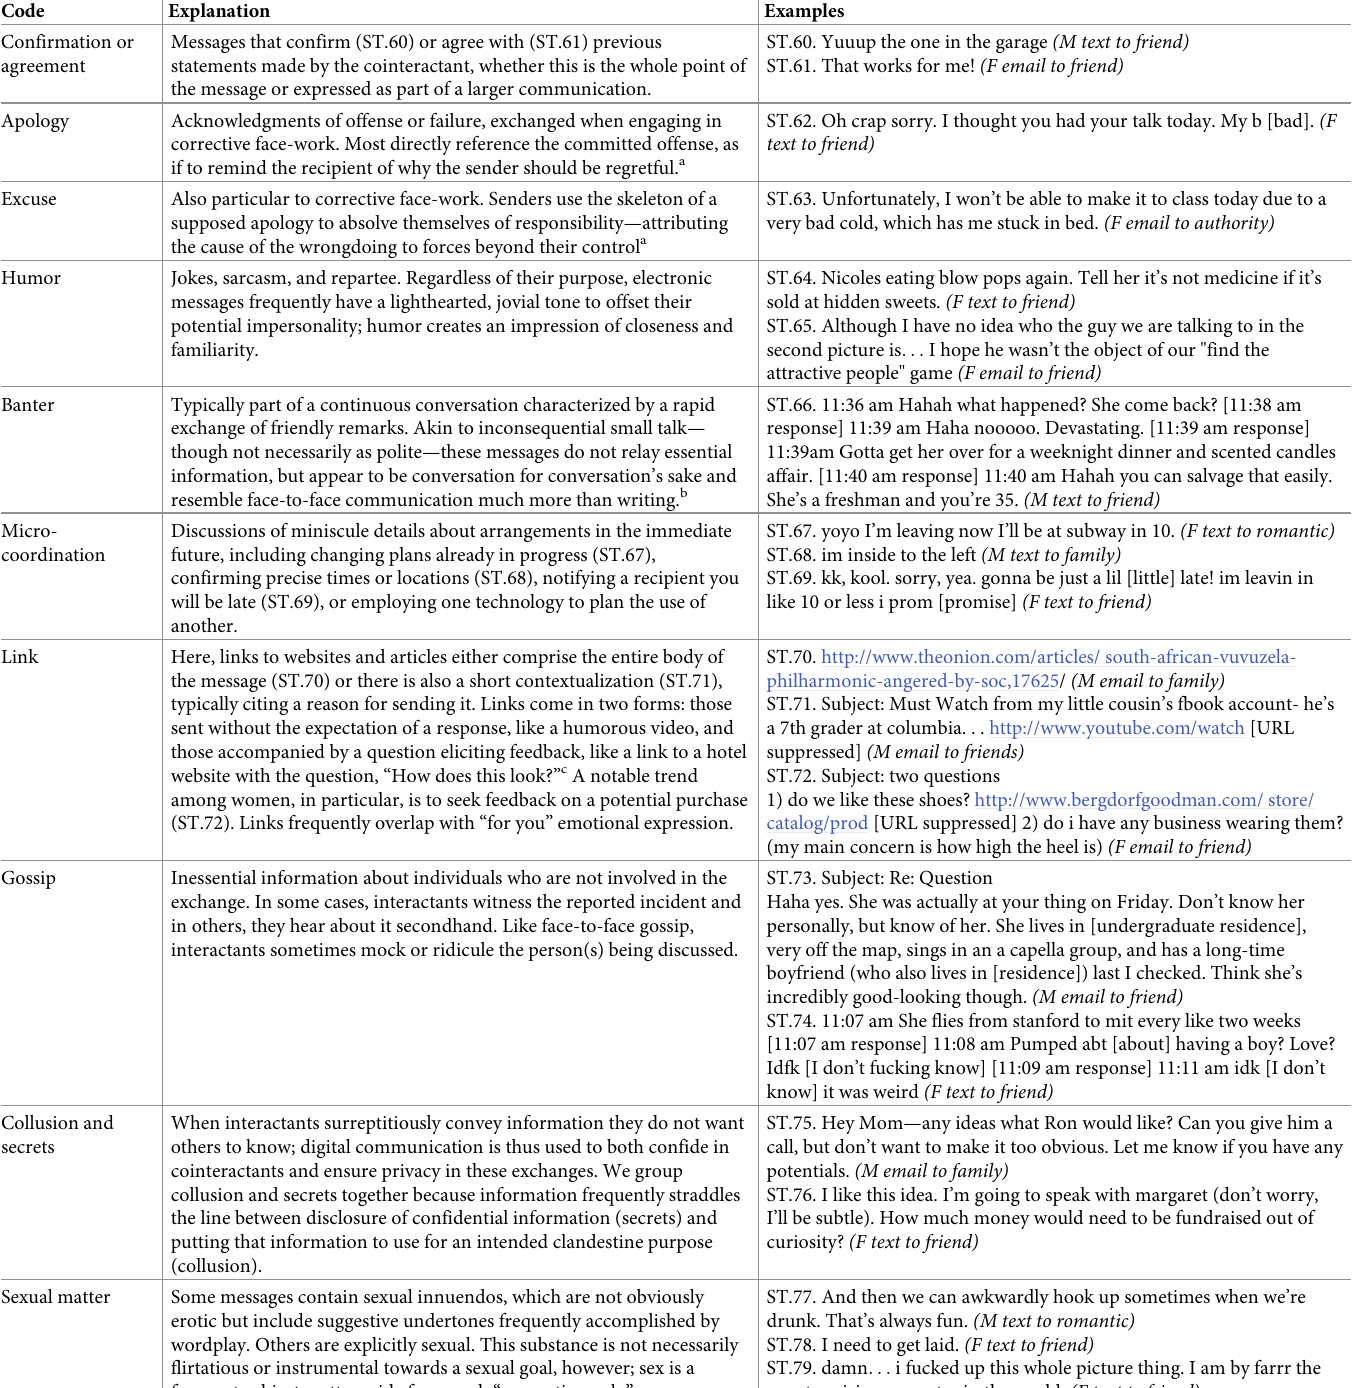
Table 4. Types of subject